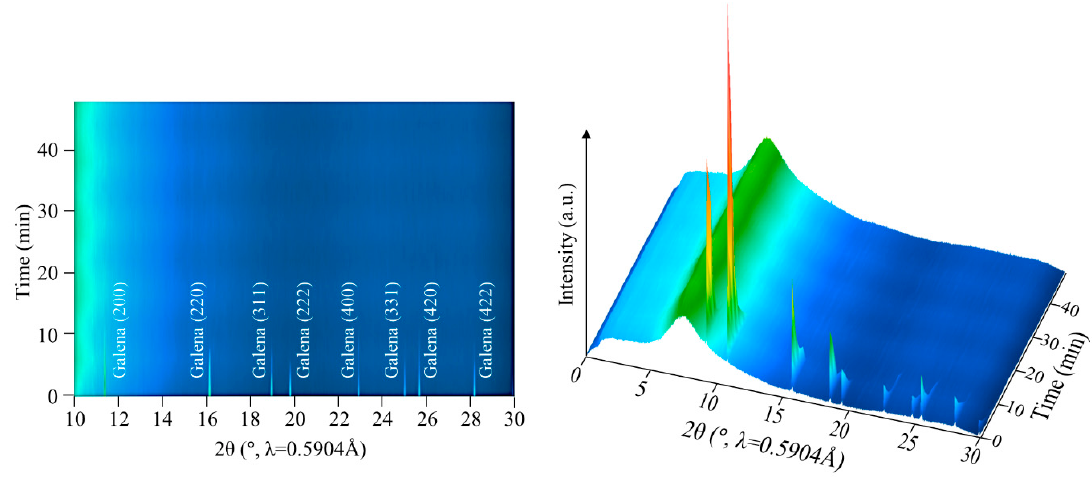
Figure 4. In-situ PXRD patterns showing rapid galena leaching at 35 ◦ C in a pH 6 Figure 4. In - situ PXRD patterns showing rapid galena leaching at 35 °C in a pH 6 solution.